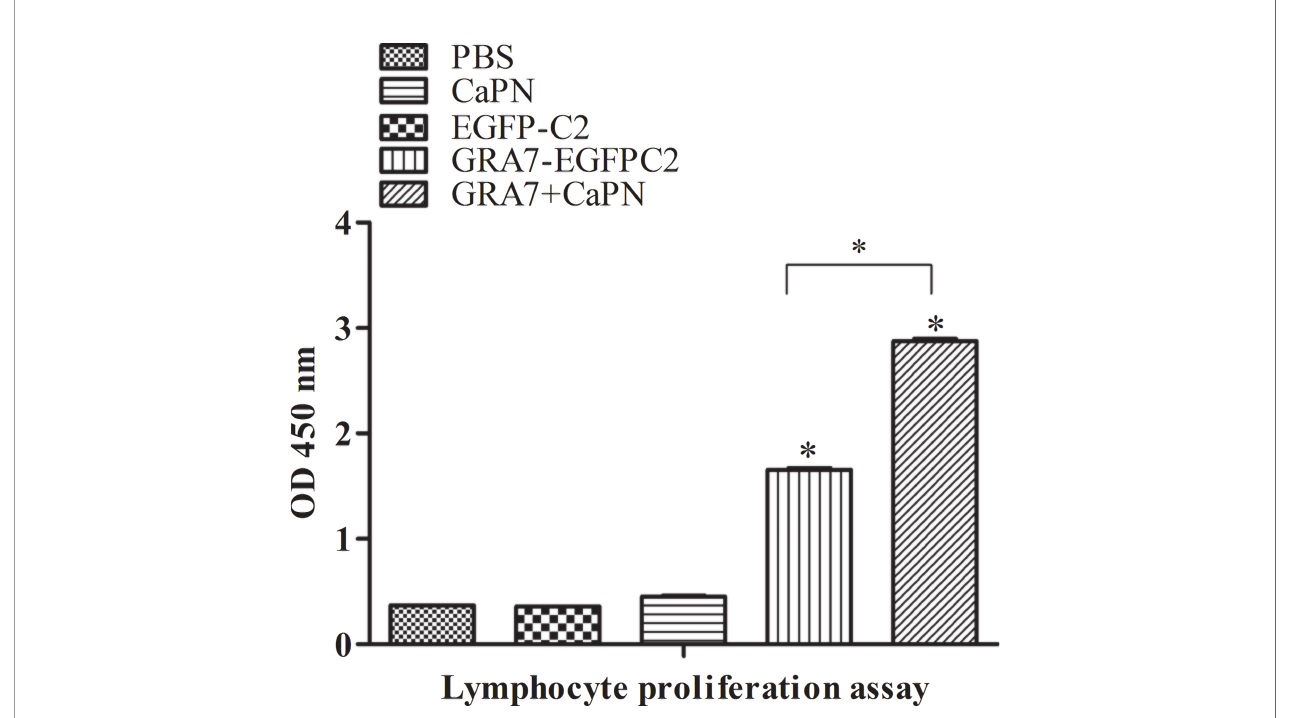
FIGURE 4 | Splenocyte proliferation response in BALB/c mice. Splenocytes from immunized mice and non-immunized mice were collected 63 days after immunization, and the proliferation response was analyzed by Cell Counting Kit (CCK)-8 assay. The data are shown as the means ± SD of three independent experiments. * P <